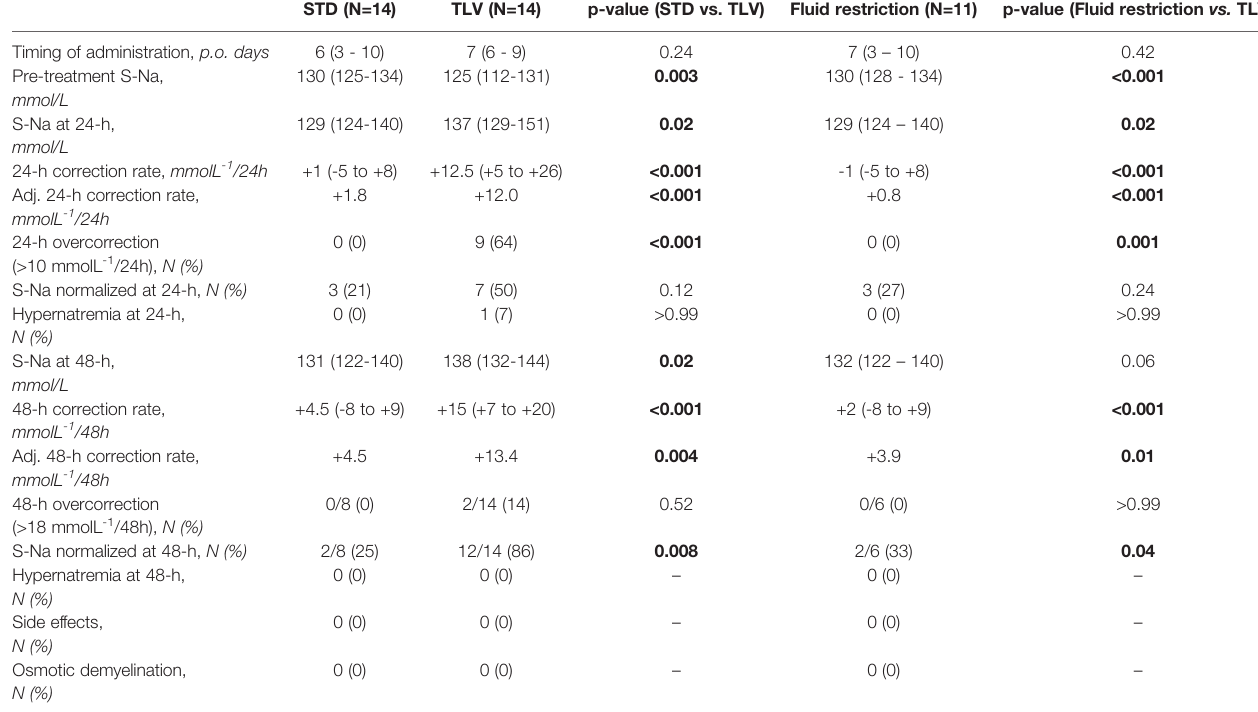
TABLE 2 | Outcomes of standard treatments (STD, N=14, including fl uid restriction and/or hypertonic saline), tolvaptan (TLV, N=14), and fl uid restriction only (excluding hypertonic saline, N=11) in the management of post-operative hyponatremia. STD (N=14) TLV (N=14) p-value (STD vs. TLV) Fluid restriction (N=11) p-value (Fluid restriction vs. TLV) Timing of administration, p.o.